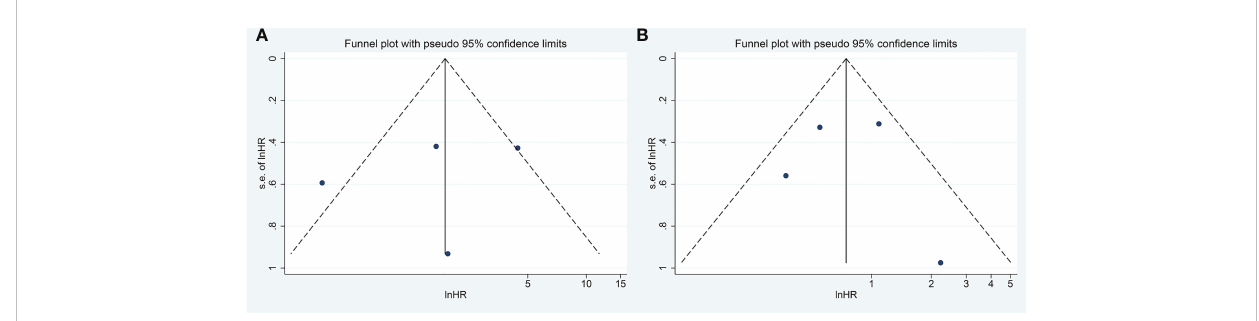
FIGURE 4 Funnel Plots to detect publication bias. (A) Funnel Plots to detect publication bias for meta-analysis of FASN expression level and DFS/RFS. (B) Funnel Plots to detect publication bias for meta-analysis of FASN expression level and OS. FASN, fatty acid synthase; DFS, disease-free survival; RFS, relapse- free survival; OS, overall